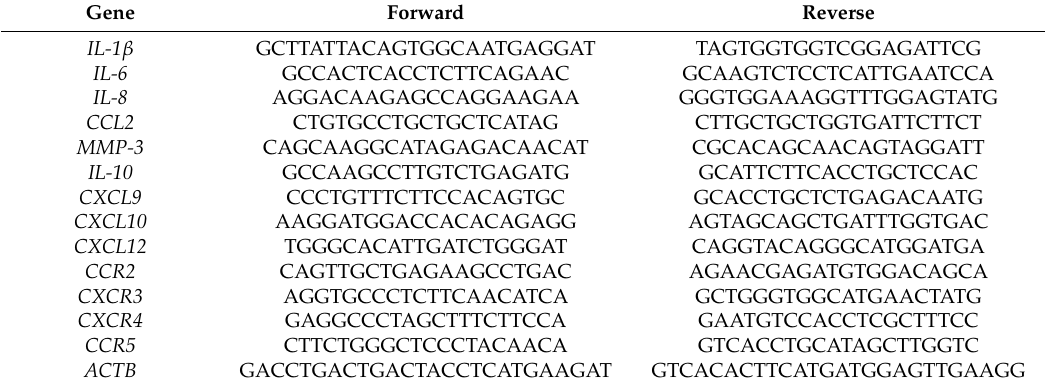
Table 1. Primer sets used for quantitative real time PCR